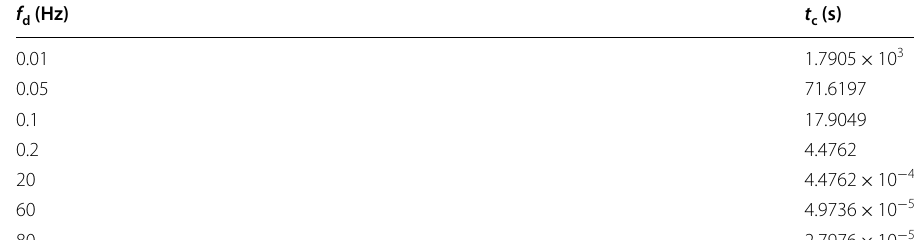
Table 1 The corresponding relation between f f d (Hz)